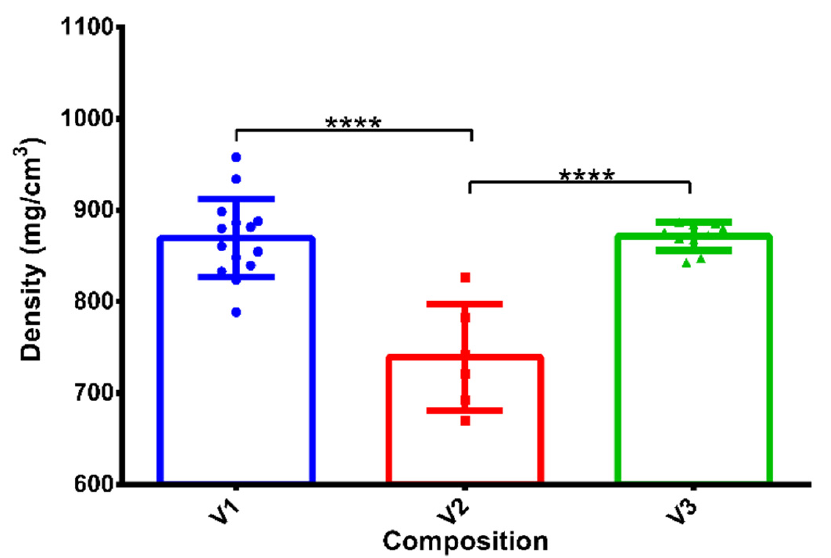
Figure 2. Densities of compositions V1-V3. V2 had the significantly lowest density value. **** indicates statistically significant differences at p < 0.0001. The measured values, average values, and standard deviations are presented ( n = 20).